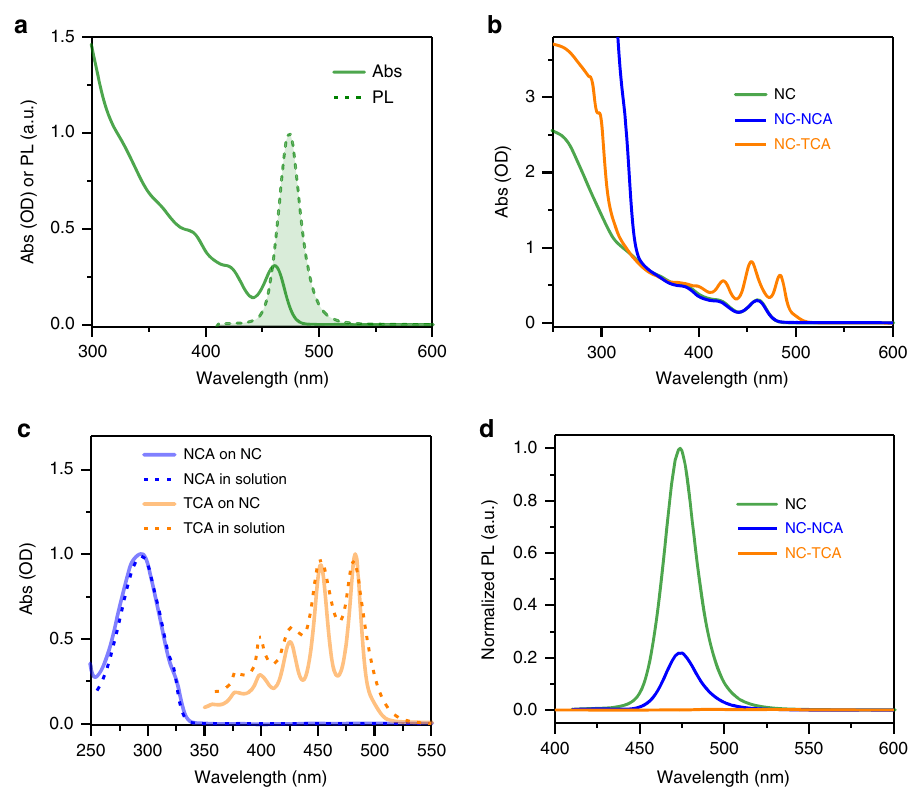
Fig. 3 Optical properties of the NC-PAH systems. a Absorption (Abs; solid line) and photoluminescence (PL; dashed line with shading) spectra of CsPbBr 3 NCs. b Absorption spectra of CsPbBr 3 NCs (green), NC-NCA (blue) and NC-TCA (orange) complexes dispersed in hexane. c Absorption spectra of NCA and TCA on NC surfaces (blue and orange solid lines, respectively) obtained from spectral differences in ( b ) and absorption spectra of NCA and TCA dissolved in toluene (blue and orange dashed lines, respectively). d PL spectra of CsPbBr 3 NCs (green) and NC-NCA (blue) and NC-TCA (orange) complexes dispersed in